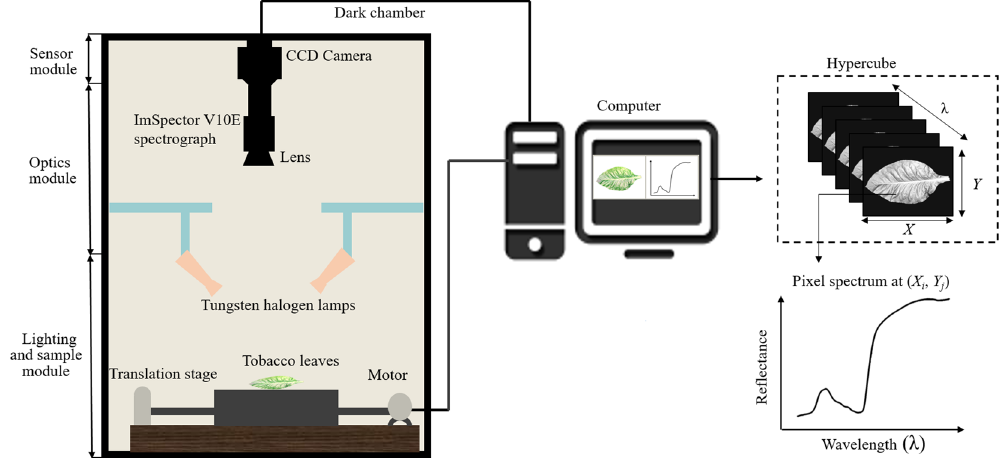
Figure 5. Configuration of the hyperspectral imaging system. The system acquired hyperspectral images at the spectral range of 380–1023 nm with 512